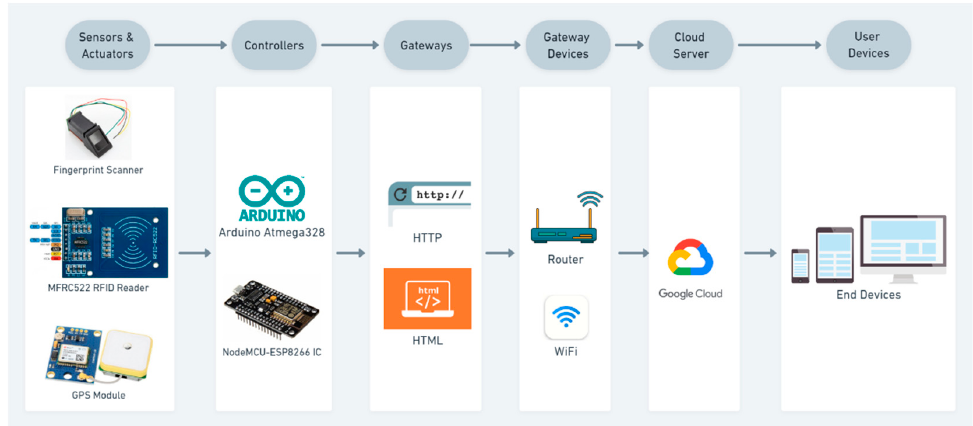
Figure 1. IoT system architecture of the proposed system.